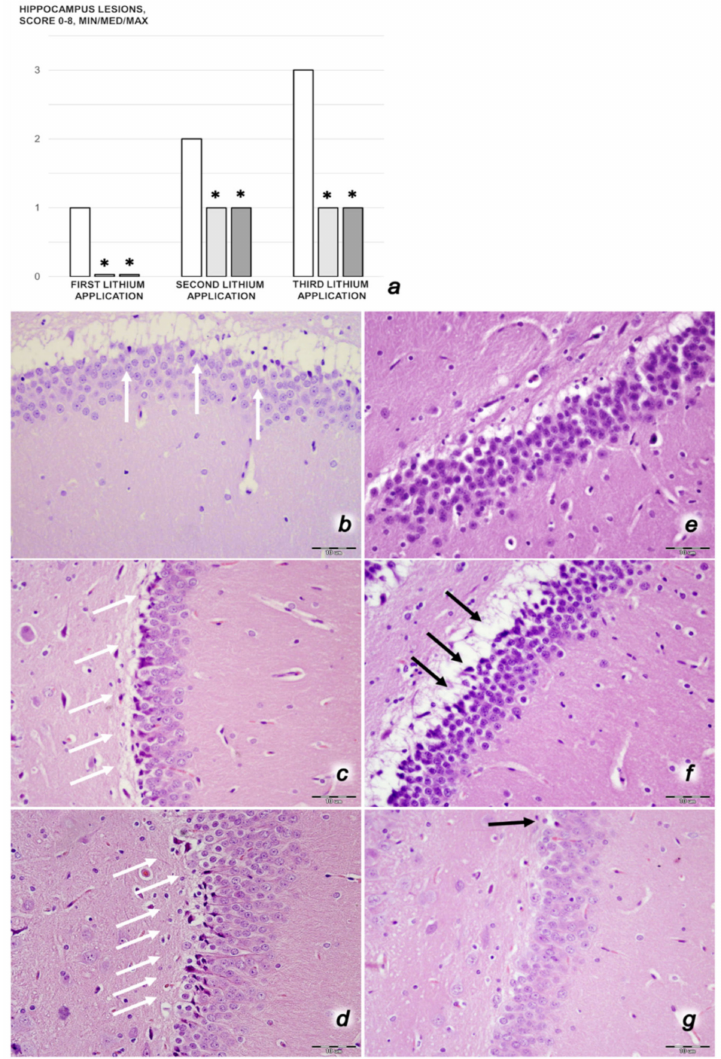
Figure 17. Brain pathology. Neuropathological changes of the hippocampus. ( a ) Semiquantitative microscopy scoring of the hippocampal lesions in the lithium-treated rats after the first, second, and third lithium administration (500 mg/kg/day intraperitoneally for 3 consecutive days). BPC 157 10 µ g/kg (light gray bars), 10 ng/kg (dark gray bars); saline 5 mL/kg (white bars) given intraperi- toneally after each of the three lithium administrations. Six rats/group/interval. Min/Med/Max, * p < 0.05, at least vs. control. In control rats a continuous increase in the rate of affected area occurred, from grade 1 (less than 20 percent of hippocampus cortex area affected with a few karyopyknotic neuronal cells), to grade 3 (up to 75 percent of hippocampus cortex area affected with more extensive karyopyknotic areas) following the order of lithium administration, whereas in BPC 157-treated rats grade 1 neuronal changes occurred after the second and third lithium administrations, with no changes after the first lithium administration. Illustrative hippocampus histology ( b – g ). Control ( b – d ), BPC 157 ( e , f ); first lithium application ( b , e ), second lithium application ( c , f ), and third lithium application ( d , g ). A progressive karyopyknosis of pyramidal cells of the hippocampus presented in the control lithium-treated rats after each of the lithium administrations, and particularly after the third lithium administration (white arrows). In contrast, BPC 157-treated rats showed only a few, scattered karyopyknotic cells after the second and third lithium administrations (black arrows). (HE; magnification × 400, scale bar 10 µ